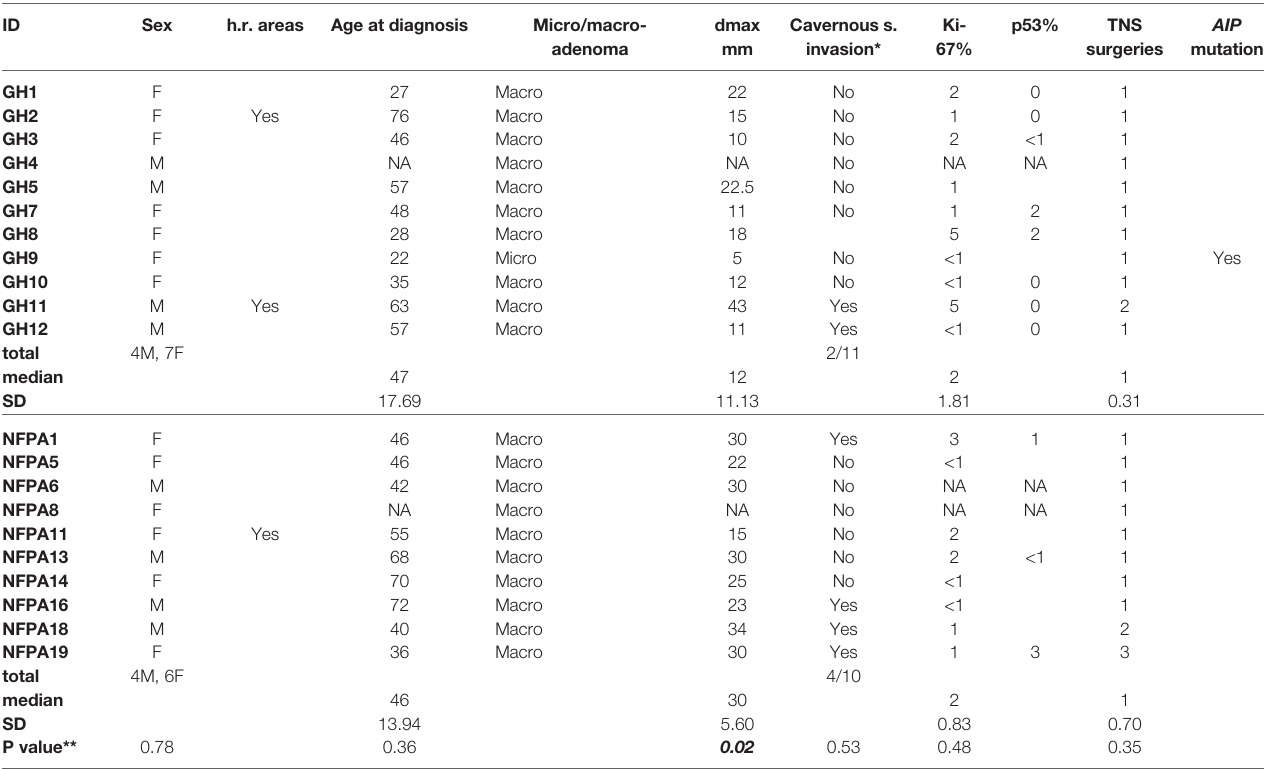
TABLE 1 | Demographic, radiological, and clinicopathological features of the studied cohort of patients. ID